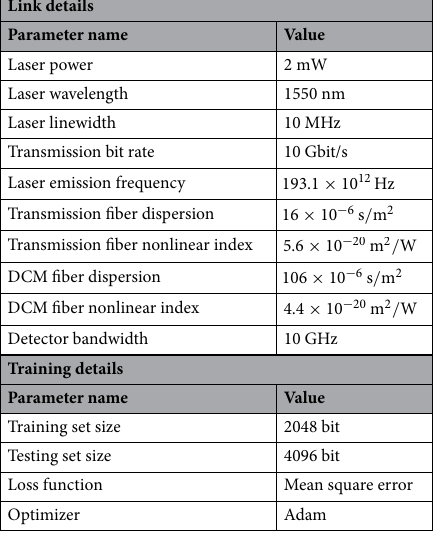
Table 1. Details of the long distance transmission link.